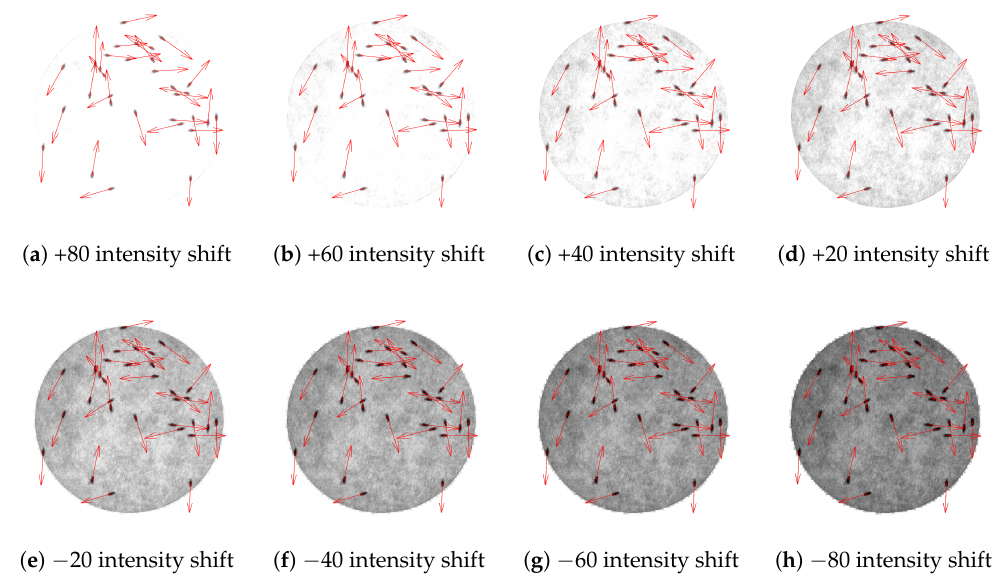
Figure 14. Heading direction results of various intensity shifting. The erroneous fly from Figure 13 in ( a – c ) appears to have the correct heading direction while ( d – h ) give the same result as the original